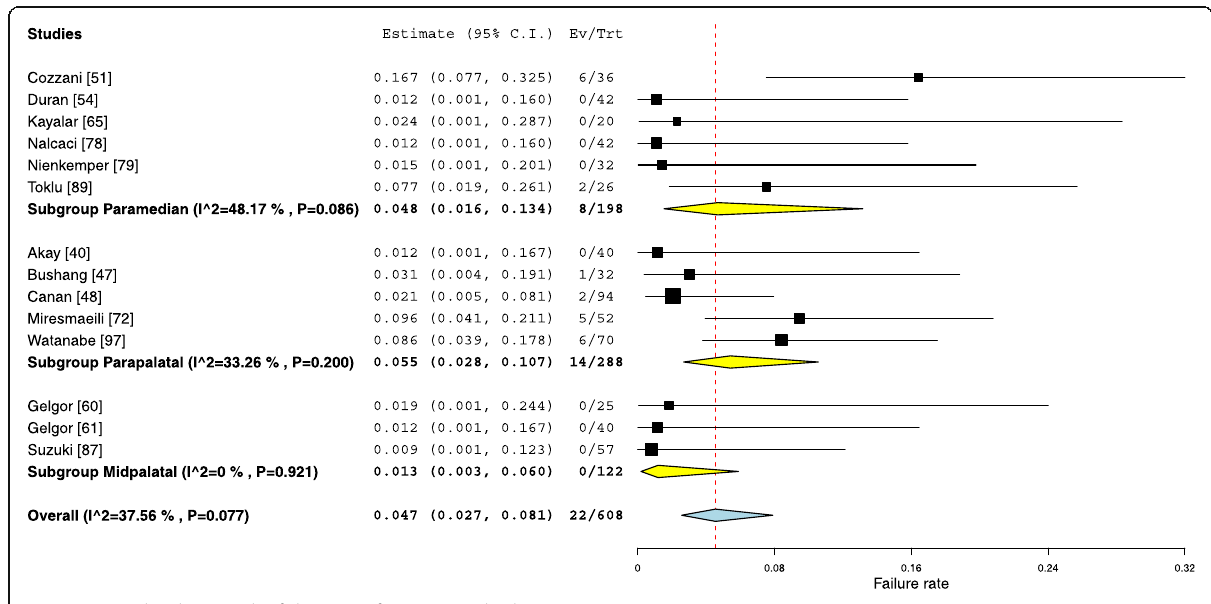
Fig. 5 Forest plot showing the failure rates for various palatal insertion